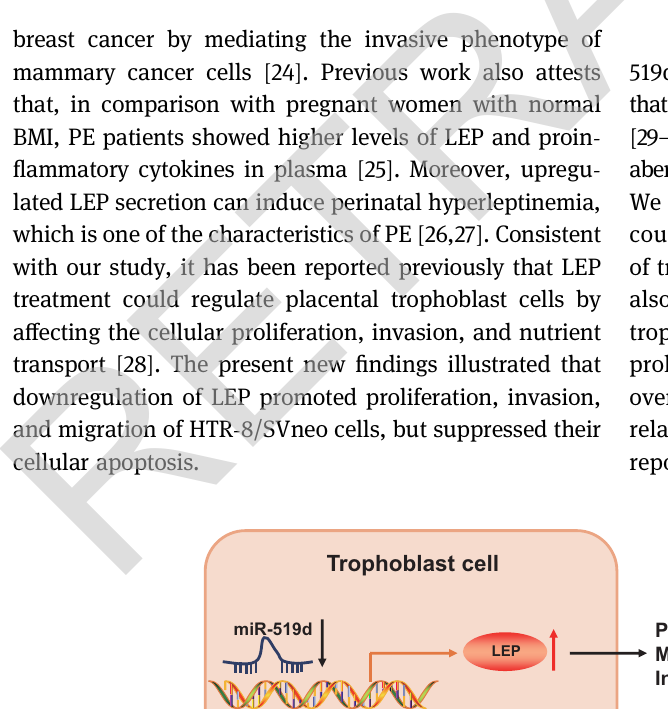
Figure 5: miR - 519d promotes the progress of HTR8/SVneo cells through LEP. ( a ) After co - transfected with miR - 519d mimic and LEP over - expression plasmid, the level of LEP in HTR - 8/SVneo cells was detected with RT - qPCR. ( b ) After co - transfected with miR - 519d mimic and LEP overexpression plasmid, the LEP protein level in HTR - 8/SVneo cells was detected by Western blot. ( c ) After co - transfected with miR - 519d mimic and LEP overexpression plasmid, the cell viability in HTR - 8/SVneo cells was tested through CCK - 8. ( d ) After co - transfected with miR - 519d mimic and LEP overexpression plasmid, the cloning ability in HTR - 8/SVneo cells was tested using clone formation assay. ( e ) After co - transfected with miR - 519d mimic and LEP overexpression plasmid, the cell cycle in HTR - 8/SVneo cells was detected using fl ow cytometry. ( f ) Scratch test was used to measure the migration ability of HTR - 8/SVneo cells, which were co - transfected by miR - 519d mimic and LEP overexpression plasmid. ( g ) Transwell test was used to measure invasion of HTR - 8/SVneo cells, which were co - transfected by miR - 519d mimic and LEP overexpression plasmid. ( h ) After co - transfected with miR - 519d mimic and LEP overexpression plasmid, the apoptosis of HTR - 8/SVneo cells was measured with fl ow cytometry; * indicates P < 0.05 ( the result was measurement data, expressed as mean ± standard deviation, and single factor analysis of variance was used for multigroup data comparison; Data at various time points were analyzed with two - factor analysis of variance, and the tests were repeated in triplicate ) .